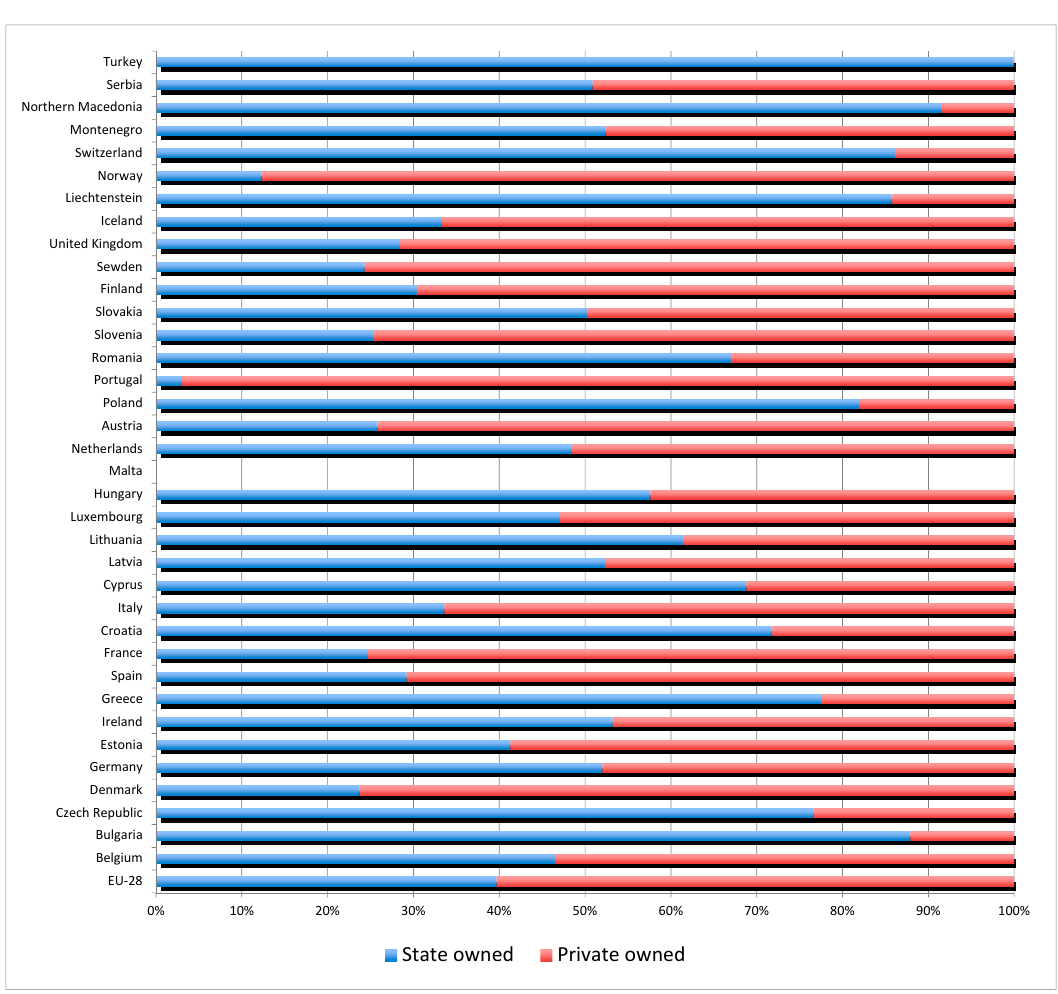
Figure 3. Distribution (%) of ownership of forest property in European countries (adapted from [42]). The same “Forest Profile” states that “there are 11.7 million rustic buildings registered in the matrix (therefore with agricultural or forest use), and only 46% of forest areas have a land register. It